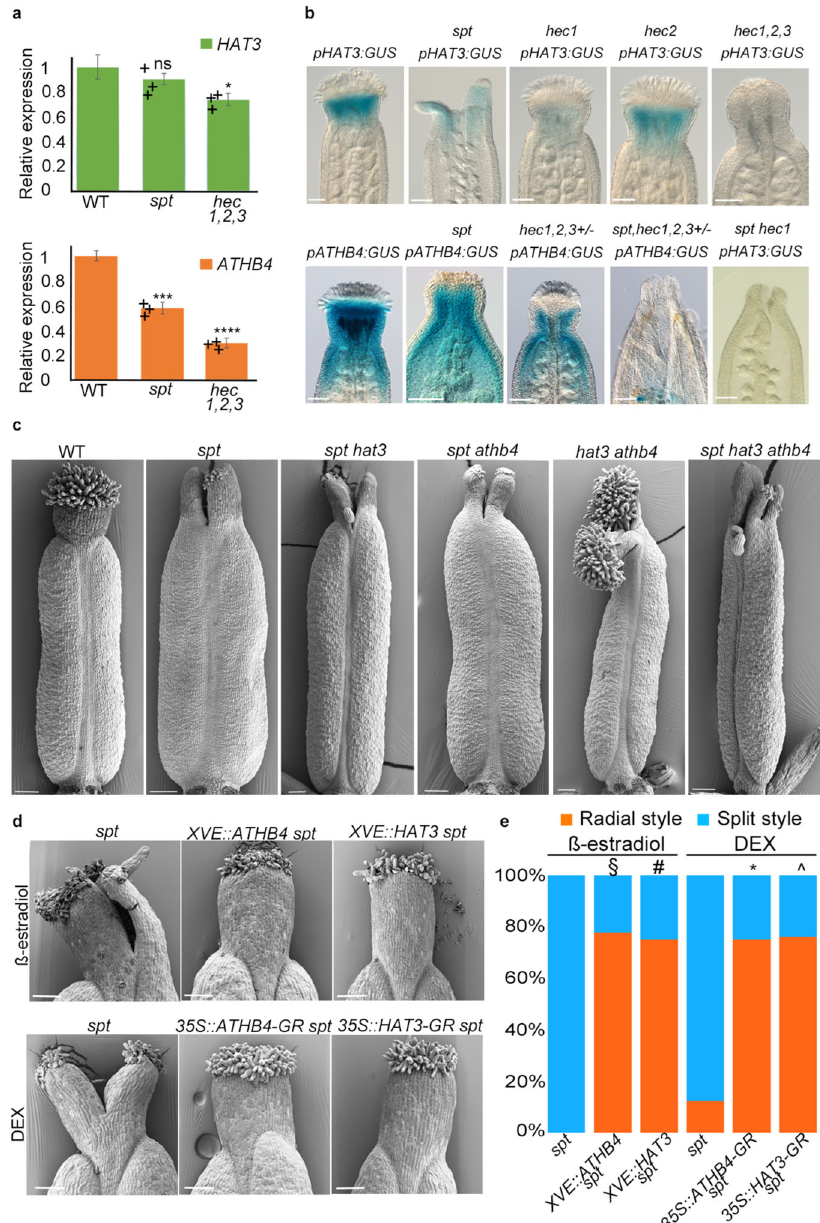
Fig. 2 SPT/HEC synergistic control of HAT3 and ATHB4 expression and genetic analyses. a qRT-PCR of HAT3 and ATHB4 in Col-0, spt and hec1,2,3 mutant in fl orescences normalised against UBIQUITIN10 . The centre for the error bars represents mean, while error bars represent SD; * p < 0.05, *** p < 0.001, **** p < 0.0001, ns indicates no statistically signi fi cant difference (two-sided Student ’ s t test), n = 3 technical replicates. The panel displays similar results obtained from one of three biological replicates analysed, and up to six technical replicates for each gene and for each biological replicate were performed. b Optical images of stage-12 gynoecia showing pHAT3:GUS (top) and pATHB4:GUS (bottom) expression in Col-0, spt and combinations of hec1,2,3 and spt mutants, as depicted on individual panels. c SEM images of stage-12 gynoecia of Col-0, spt , spt hat3 , spt athb4 , hat3 athb4 and spt hat3 athb4 . Scale bars represent 100 µ m. b , c Similar results were obtained from three independent experiments. d SEM images of stage-13 styles of ATHB4 ( XVE::ATHB4 and 35S::ATHB4:GR ) and HAT3 ( XVE::HAT3 and 35S::HAT3:GR ) overexpression lines in spt background, treated with either 20 µ M β -estradiol (top) or 10 µ M DEX (bottom). Scale bars represent 100 µ m. e Quanti fi cation of the radial (orange bars) and split (blue bars) style phenotype of HAT3 and ATHB4 overexpression lines ( XVE::HAT3 , XVE::ATHB4 , 35S::HAT3:GR and 35S::ATHB4:GR) in spt background treated with mock, β -estradiol and DEX. Phenotypic classes were compared using contingency 2 × 2 tables followed by Pearson ’ s χ 2 test. Two-tailed P values are as follows: spt-12 XVE::ATHB4 β - estradiol vs spt-12 β -estradiol P < 0.00001 (§); spt-12 XVE::HAT3 β -estradiol vs spt-12 β -estradiol P < 0.00001 (#); spt-12 35S::ATHB4:GR DEX vs spt-12 DEX P < 0.00001 (*); spt-12 35S::HAT3:GR DEX vs spt-12 DEX P < 0.00001 (^). P values< 0.01 were considered as extremely statistically signi fi